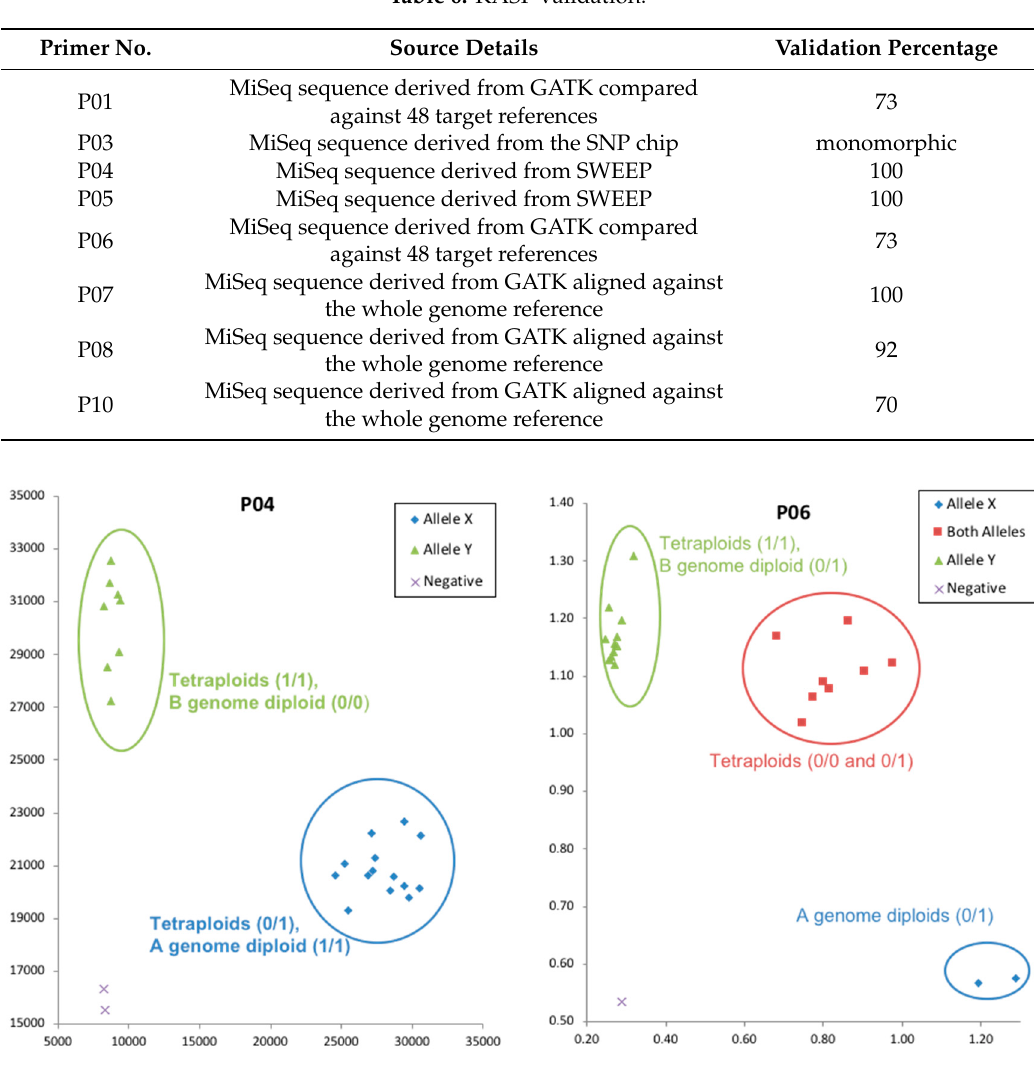
Figure 3. Example of validation of SNP calls derived from MiSeq using KASP markers.